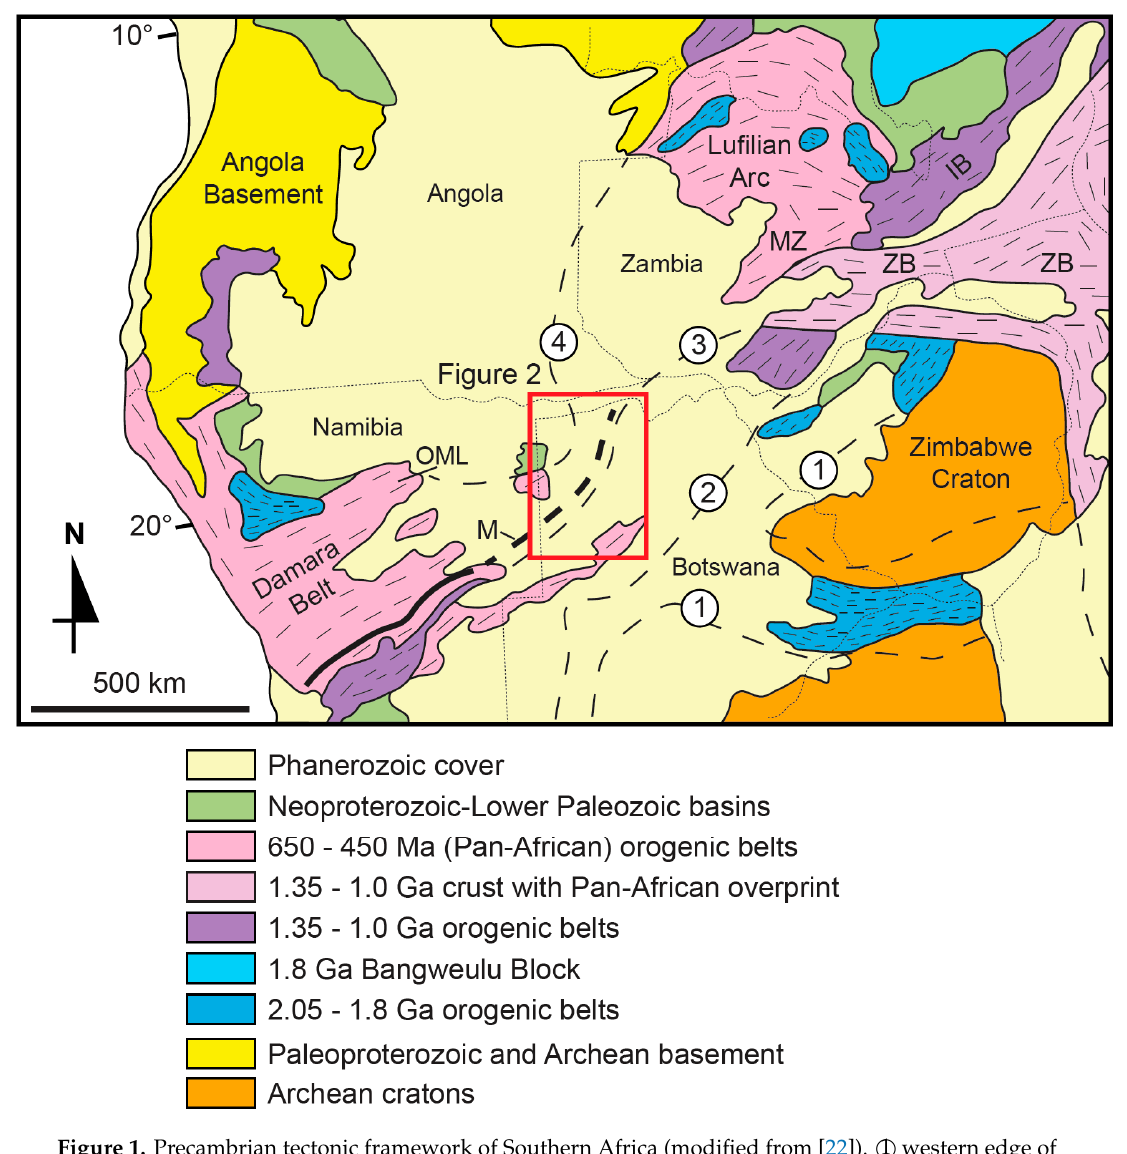
Figure 1. Precambrian tectonic framework of Southern Africa (modified from [22]). 1 (cid:79) western edge of Archaean cratons; 2 (cid:79) boundary between 2.05–1.8 Ga orogenic belts and 1.35–1.0 Ga belts; 3 (cid:79) boundary between 1.35–1.0 Ga belts and Pan-African belts; 4 (cid:79) western edge of Pan-African belts. IB = Irumide Belt; M = Matchless Belt; OML = Otavi Mountainland; ZB = Zambezi Belt. The red square indicates the position of map in Figure 2.